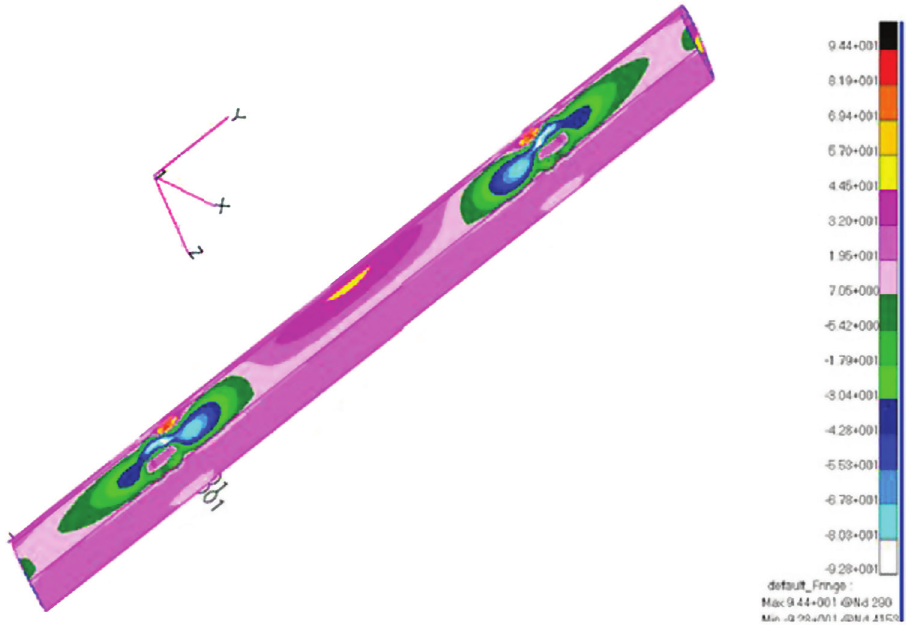
Figure 10 Spanwise (Y-axis) stress contour on the 13th ply of spar for load case 2 (MPa).